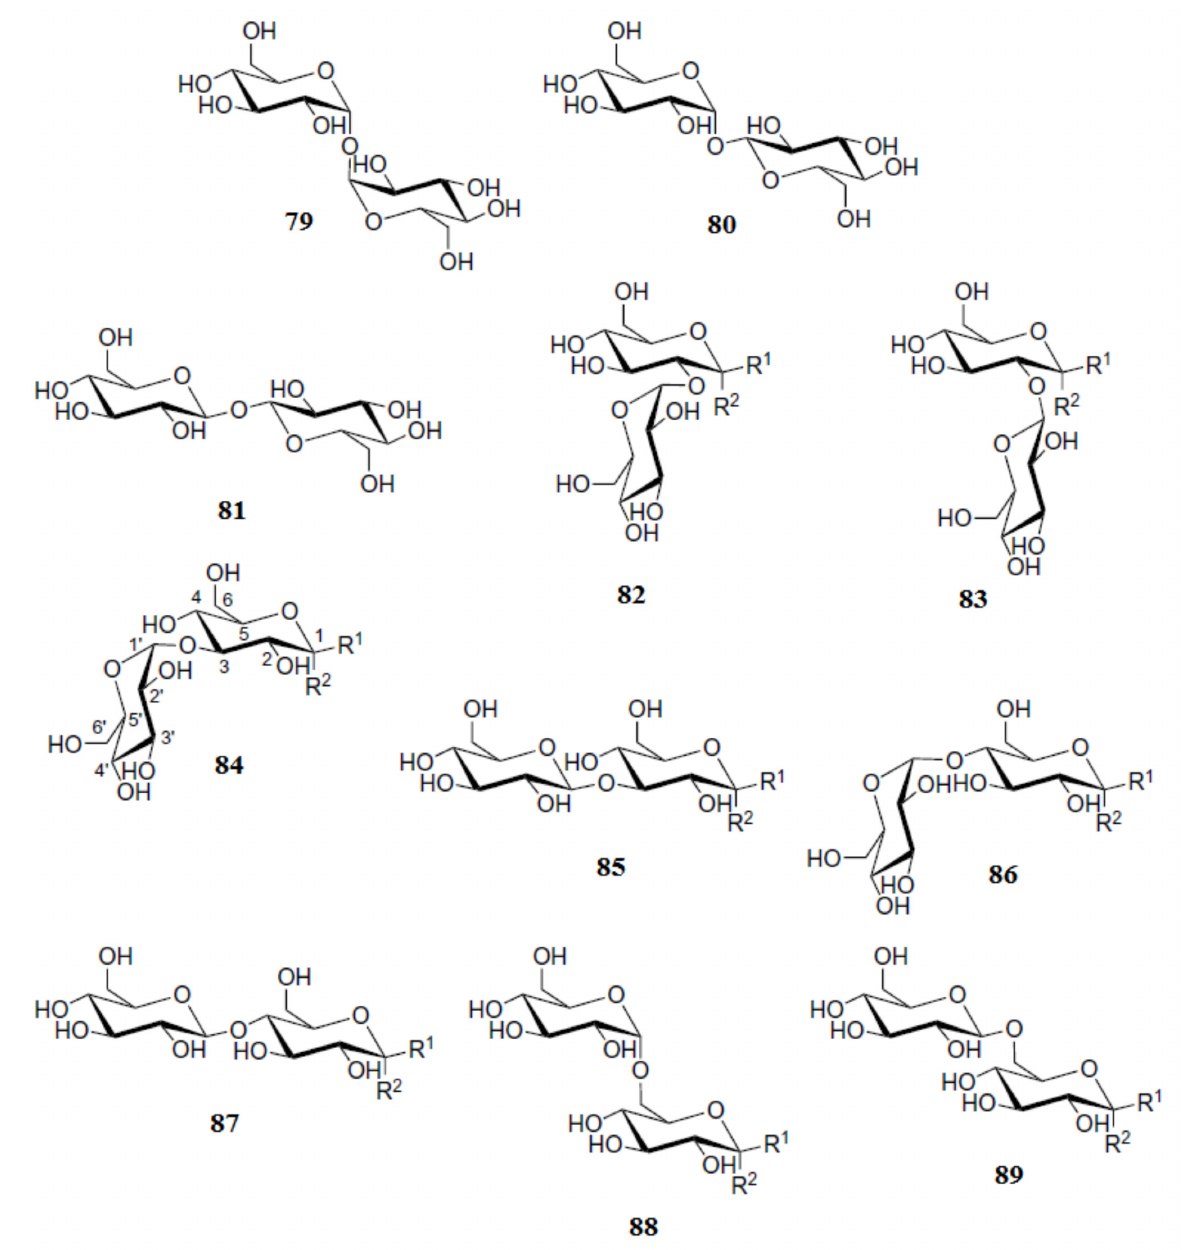
Scheme 7. Chemical structures of the glucose-based disaccharides α , α -trehalose ( 79 ), α , β -trehalose ( 80 ), β , β -trehalose ( 81 ), kojibiose ( 82 ), sophorose ( 83 ), nigerose ( 84 ), laminaribiose ( 85 ), maltose ( 86 ), cellobiose ( 87 ), isomaltose ( 88 ), and gentiobiose ( 89 ). R 1 and R 2 stand for H and OH (or either OH and H) in different anomers. Reproduced with minor editing privilege from Roslund et al. [111] with the permission of